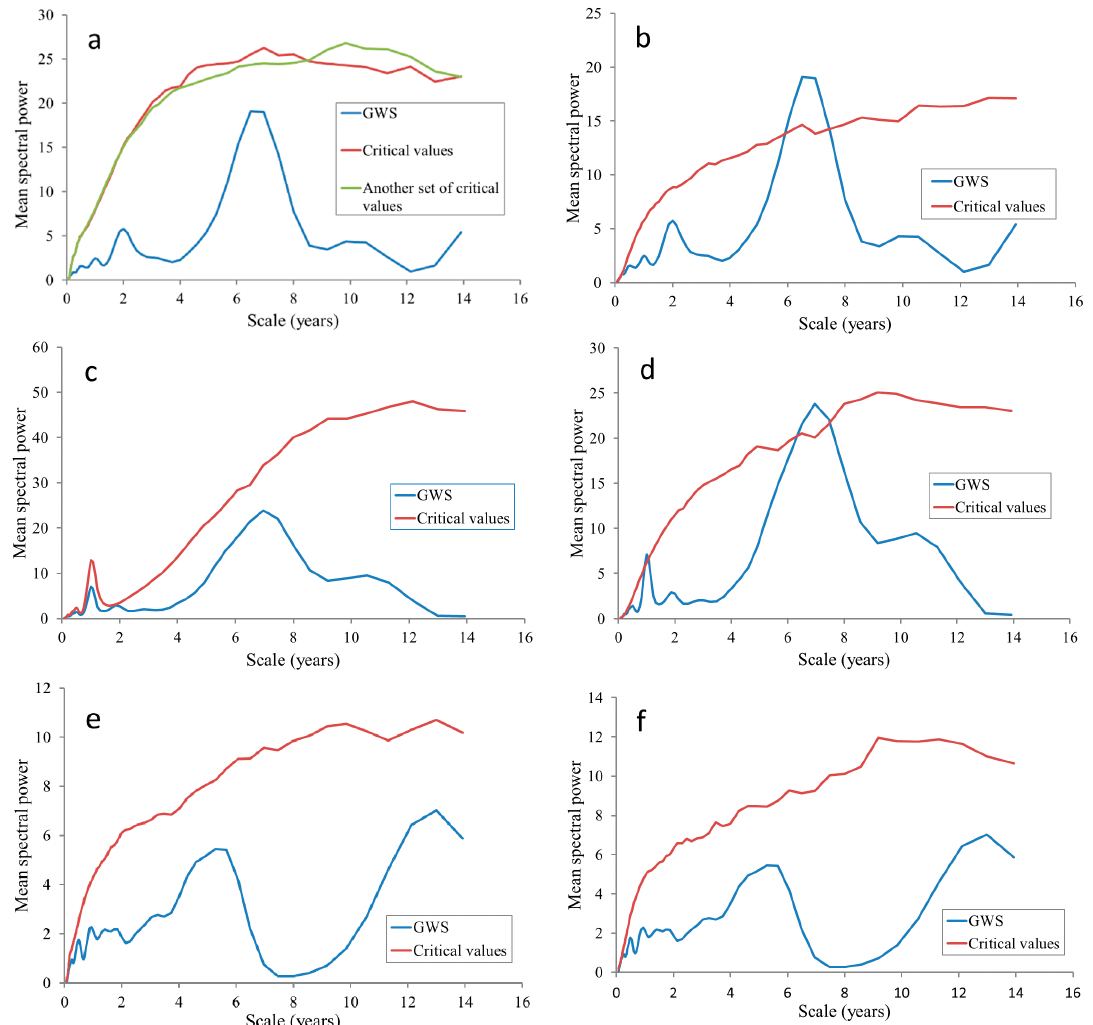
Figure 4. Global wavelet spectra (GWSs) with best fitted ARMA and AR (1) for discharge, sodium, and sulfate. y-axes represent spectral power for the time series at each scale and x-axes scales (in years). ( a ) discharge, AR (9); ( b ) discharge, AR (1); ( c ) sodium, AR (34); ( d ) sodium, AR (1); ( e ) sulfate, AR (3); ( f ) sulfate, AR (1).